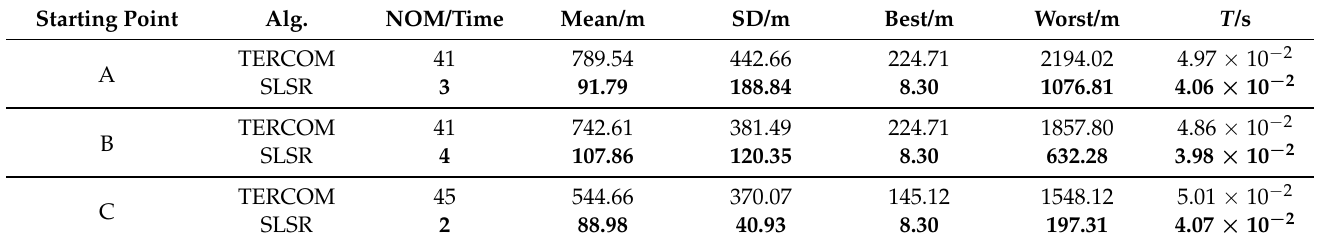
Table 5. Statistical results of out-of-domain matching under different tracking starting points.